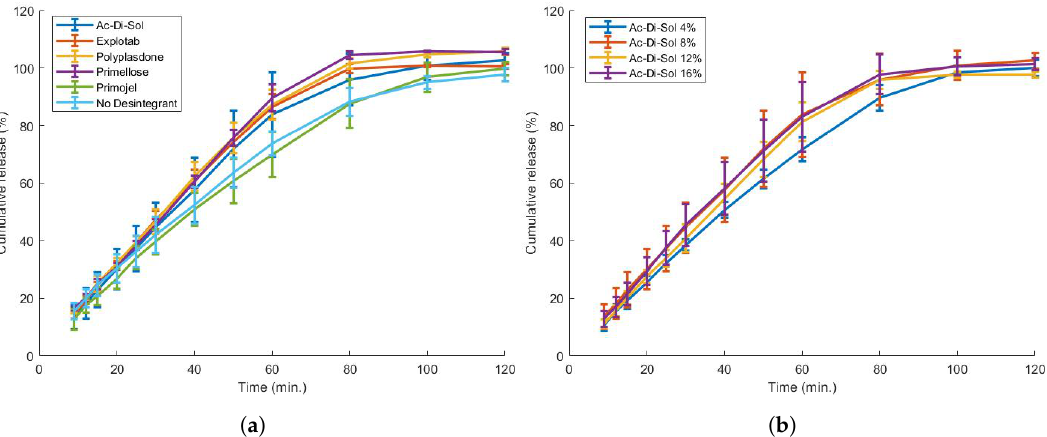
Figure 13. ( a ) The effect of disintegrant addition on the dissolution behaviour of the EPO:PEO:ZHT blend (69.3:29.7:1). Five different disintegrants were added in an 8% ratio. The addition of disintegrant seemed to marginally increase the dissolution speed, except for Primojel. ( b ) An increase in disintegrant concentration did not significantly alter the dissolution